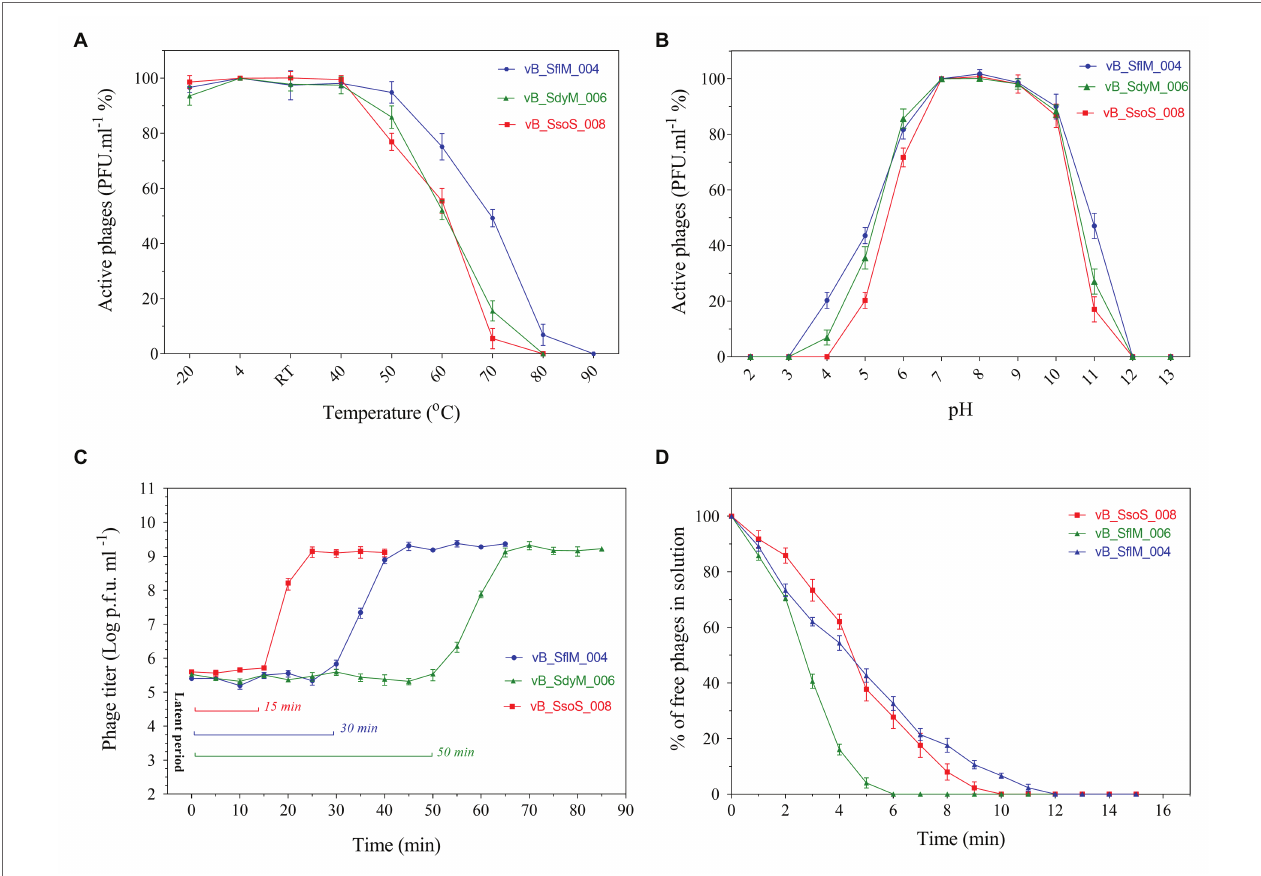
FIGURE 2 | The thermostability (A) , pH stability (B) , one-step growth curve (C), and adsorption rate (D) of vB _SflM_004, vB_SdyM_006, and vB_SsoS_008. The error bars indicate standard deviations